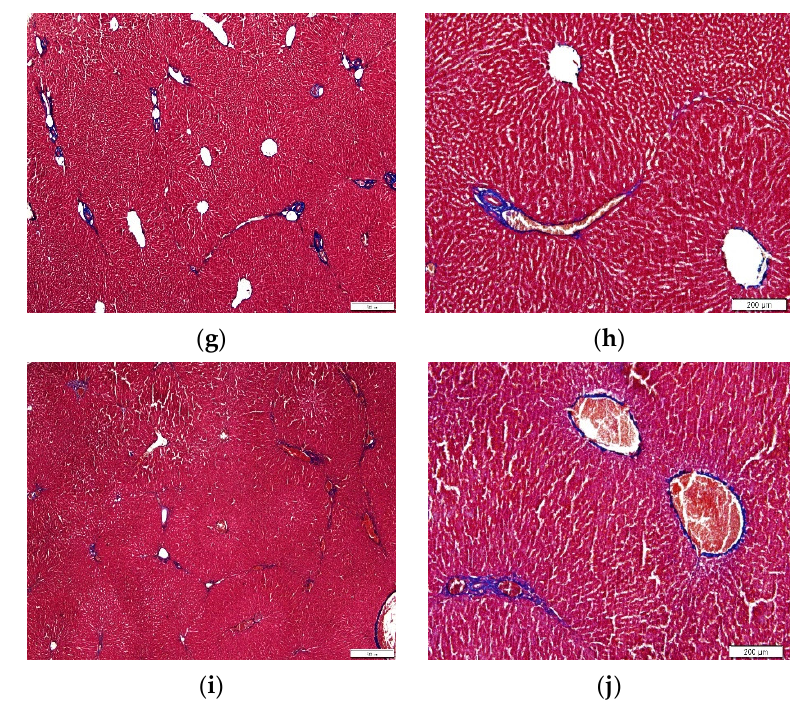
Figure 4. Images of liver tissues stained with Masson’s trichrome. ( a , b ) A relatively small amount of fibrotic tissue was found between the hepatic lobules and around the portal and central veins of the negative control rabbits. ( c , d ) A large amount of fibrotic tissue was observed between the hepatic lobules and around the portal and central veins of the positive control rabbits. ( e , f ) Similar to that in the liver of the positive control rabbits, a relatively large amount of fibrotic tissue was found between the hepatic lobules and around the portal and central veins of 10 μg VLP-vaccinated rabbits. ( g , h ) Similar to that in the liver of the negative control rabbits, a relatively small amount of fibrotic tissue was found between the hepatic lobules and around the portal and central veins of 50 μg VLP-vaccinated rabbits. ( i , j ) A relatively small amount of fibrotic tissue was found between the hepatic lobules and around the portal and central veins of 100 μg VLP-vaccinated rabbits compared to positive control rabbits.